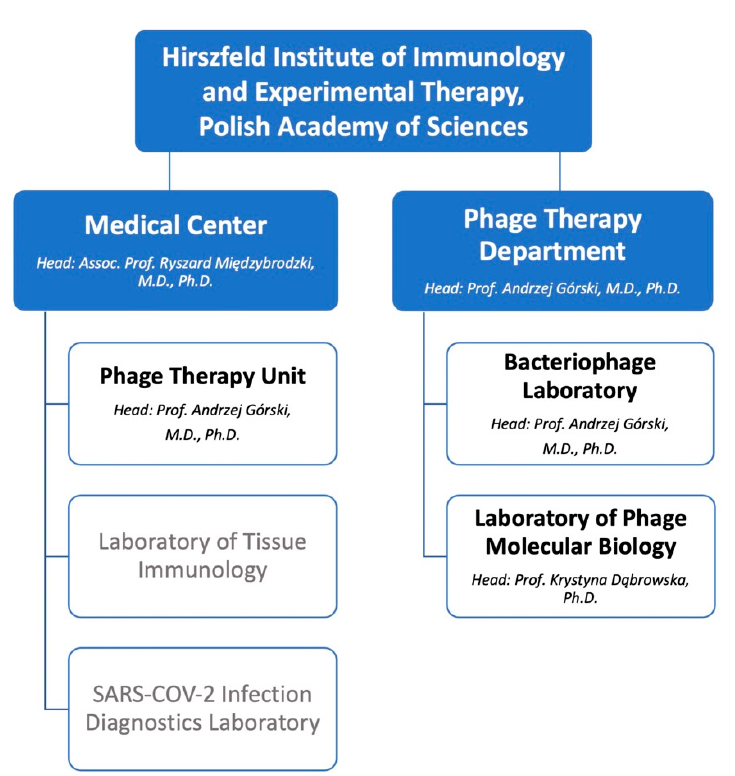
Figure 2. Organizational structure of phage-related units (highlighted in bold) within the Hirszfeld Institute as of April 2022 (along with the heads of individual units).